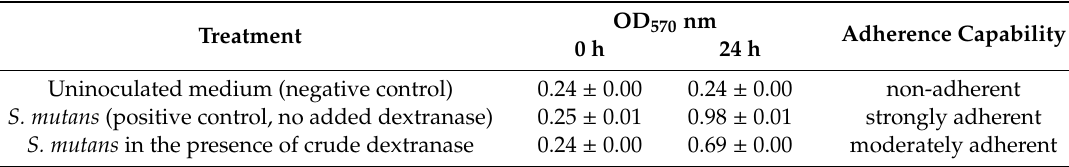
Table 1. The e ff ect of crude dextranase from Penicillium roquefortii tistr 3511 on the biofilm-adherent capability of Streptococcus mutans atcc 25175.